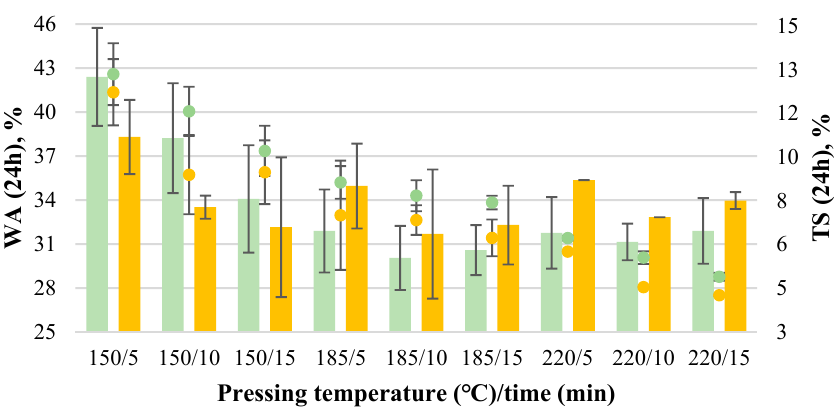
Figure 9. WA and TS of binder-less boards with a density of 1000 kg m − 3 depending on the crop and pressing variables.